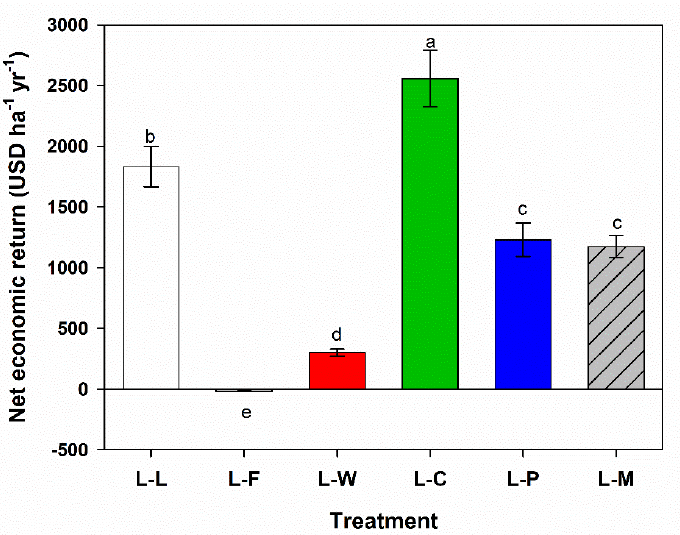
Figure 8. Average net economic return of lucerne-to-crop conversion in October from 2012 to 2018. Different letters indicate treatment means that are significantly different ( p ≤ 0.05). Error bars indicate standard deviations of the means ( n = 3). Treatment abbreviations are defined in Table 1.